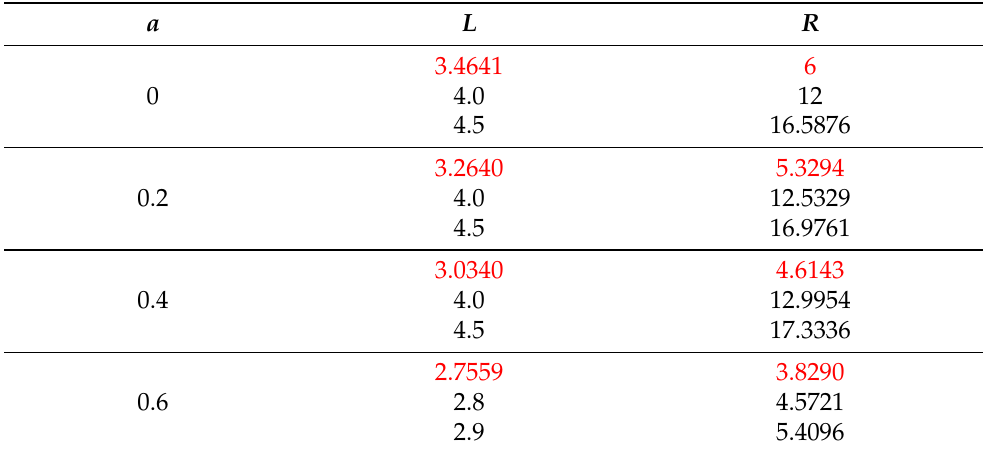
Figure 3. Effective potentials for several black hole spins a . The other parameters are L = 2 B ∗ = 0.001 and Q ∗ = 0.004. Table 3. Radii R of stable circular orbits in the Kerr spacetime of Figure 4. The radii R colored red are those of the innermost stable circular orbits